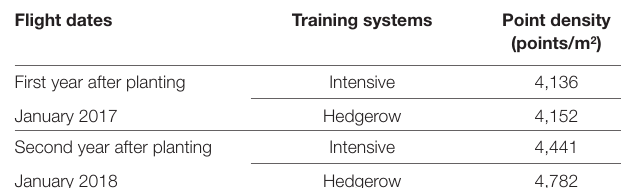
TABlE 1 | Point density for each flight date and training